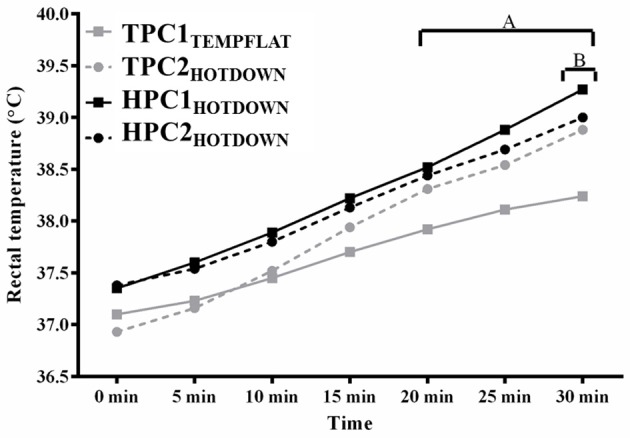
Rectal temperature (Tre) at 0–30 min of exercise. A, Tre increased (p < 0.005) during TPC2HOTDOWN compared to TPC1TEMPFLAT. B, Tre decreased (p = 0.017) during HPC2HOTDOWN compared to HPC1HOTDOWN. Mean data presented. Error bars omitted to maintain clarity.